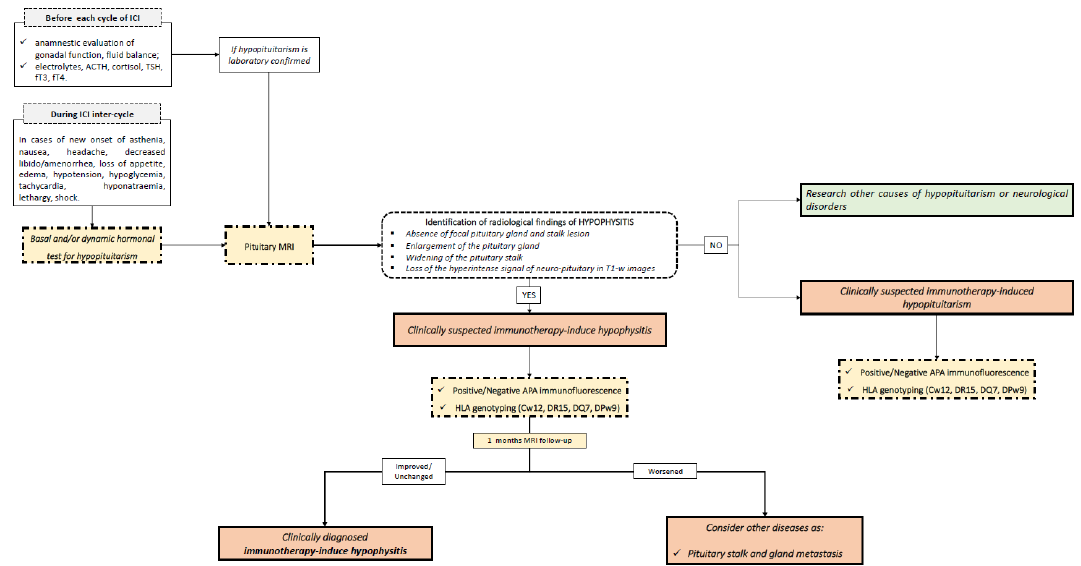
Figure 2. Flow-chart for the diagnosis of immunotherapy-induced hypophysitis and immunotherapy-induced hypopituitarism. ACTH: adrenocorticotropic hormone; TSH: thyroid stimulating hormone; fT3: free triiodothyronine; fT4: free triiodothyronine; APA: anti-pituitary antibodies; HLA: human leukocyte antigen.